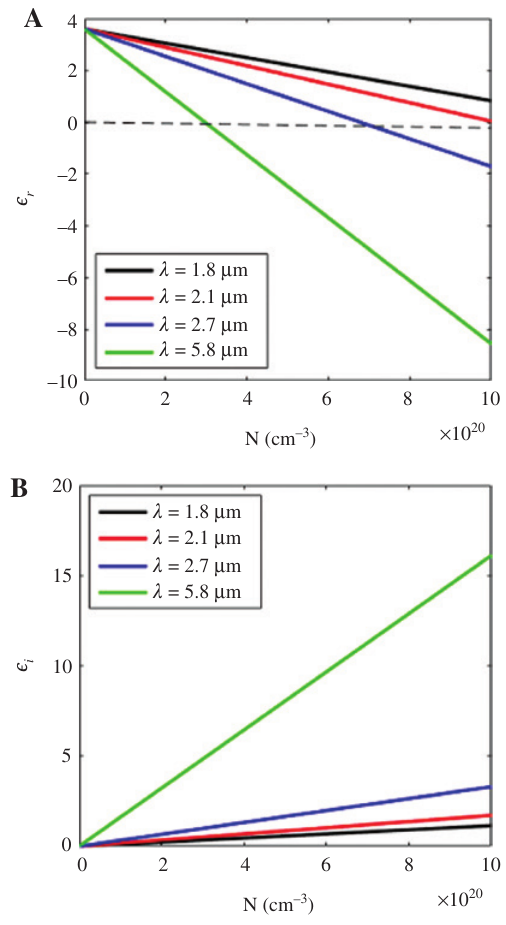
Figure 7: The permittivities of the ISO thin film at the wavelengths of 1.8, 2.1, 2.7 and 5.8 μ m.